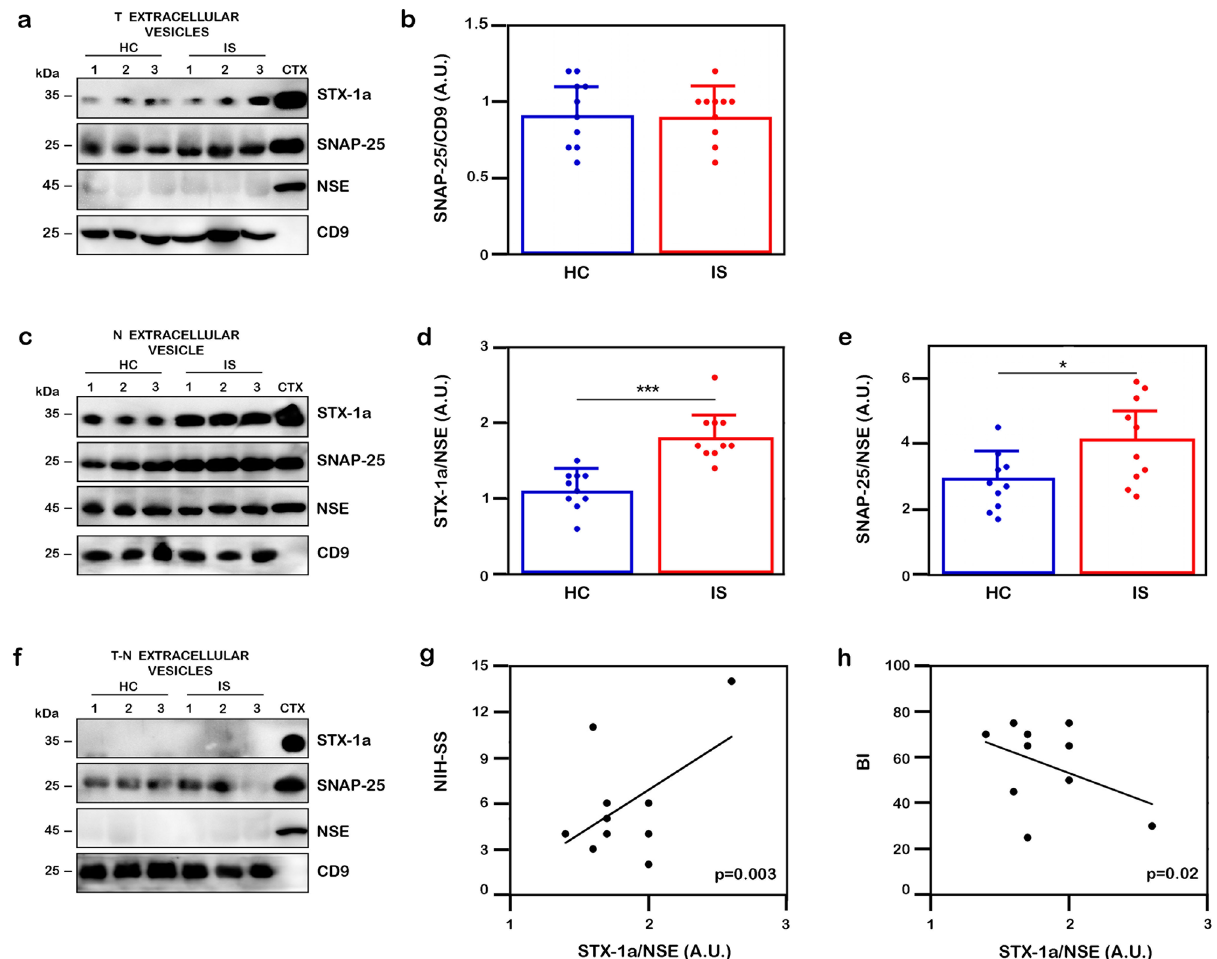
Figure 6. Analysis of SNARE in extracellular vesicles of IS and HC subjects. ( a , c , f ) Representative WB analysis of the expression levels of STX-1a and of SNAP-25 in extracellular vesicles derived from sera. Representative WB analysis of total (T) extracellular vesicles ( a ), NDE (N) ( c ) and total extracellular vesicles depleted of NDE (T-N) ( f ) fractions. Each sample has been tested against CD9 (total exosomes marker), NSE (NDE marker), STX-1a and SNAP-25. The SNAP-25 densitometric values in total extracellular vesicles fraction have been normalized to that of CD9 ( a ), while the STX-1a and SNAP-25 densitometric values in NDE have been normalized to that of NSE ( c ). ( b , d , e ) Densitometric analysis of STX-1a and SNAP-25 in extracellular vesicles The normalized SNAP-25 levels in T extracellular vesicles ( b ) and those of both STX-1a ( d ) and SNAP-25 ( e ) in NDE have been analyzed by using One-way ANOVA with post-hoc Tukey test. Both STX-1a and SNAP- 25 expression levels are significantly increased in NDE of IS patients with respect to HC subjects (p ≤ 0.0001 and p ≤ 0.02 for STX-1a ( d ) and SNAP-25 ( e ) respectively), while no differences is observed for SNAP-25 in the T fraction (p = 0.91) ( b ). ( g , h ) Pearson’s correlation analysis between expression of STX-1a in IS NDEs and the clinical stroke. STX-1a levels in NDE of IS patients present a moderate positive correlation with NIH-SS (p = 0.003) ( g ) and a moderate negative correlation with BI (p = 0.02) ( h ). For WB analysis 50 µg of each extracellular vesicles fraction and 0.5 µg of mouse brain cortex lysate have been loaded in each lane. In quantitative graphs (panels b , d and e ) each point in a frame depicts the value for a single subject (n = 10 IS patients and 10 HC subjects) while bars represent the median value ± SD. *p ≤ 0.05; ***p ≤ 0.001. In panels ( b ), ( d ) and ( e ) blue points and histograms correspond to HC subjects, red points and histograms correspond to IS patients. Uncropped WB in ( a ), ( c ) and ( f ) have been reported in Fig. S9